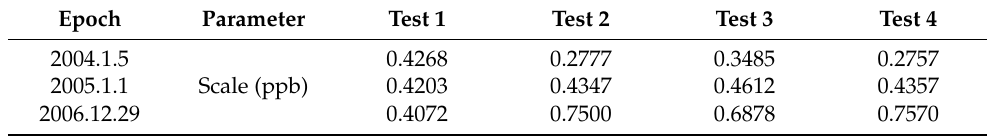
Table 2. The scale parameters of four long-term solutions with respect to the ITRF2014 VLBI solution.